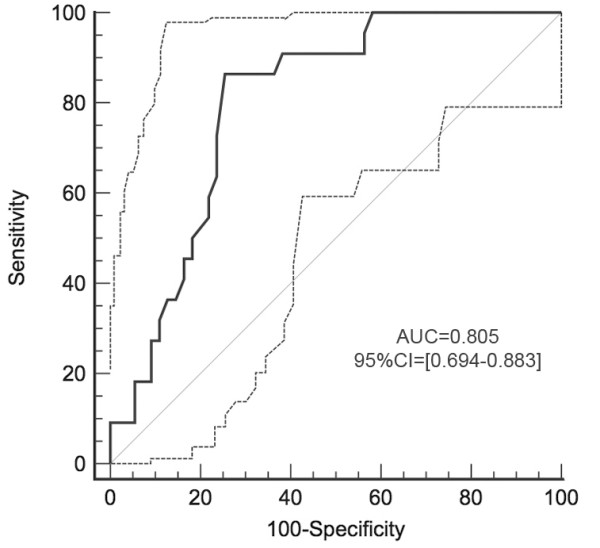
Receiver-operator characteristic curves of the performance of optical nerve sheath diameter to predict mortality. Dotted lines represent 95% confidence intervals (95% CI) of each point. AUC, area under the curve.